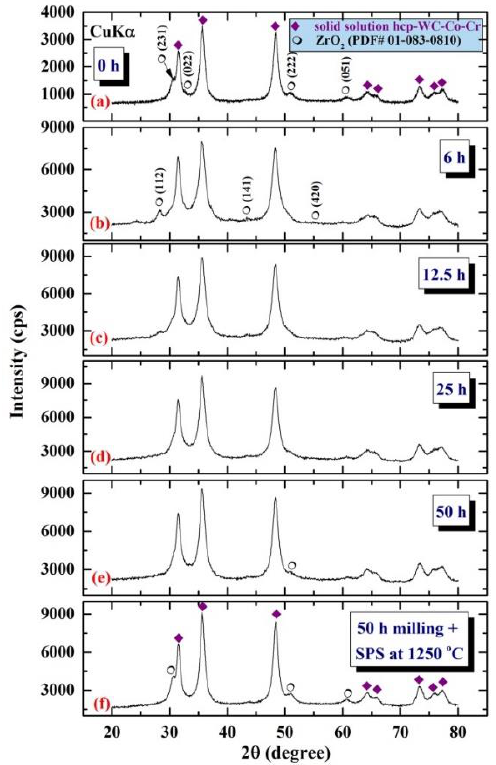
Figure 25. XRD patterns of 93-WC/7 wt. % (10Co/4Cr) powders after 50 h of milling and then mixed with 7 wt. % (ZrO 2 ) powders for ( a ) 0, ( b ) 6, ( c ) 12.5, ( d ) 25, and ( e ) 50 h. ( f ) shows the XRD pattern of nanocomposite 93(93-WC/7 wt. % (10Co/4Cr))/7 wt. % ZrO 2 . The HRTEM image of 93(93-WC/7 wt. % (10Co/4Cr))/7 wt. percent ZrO 2 powders generated after 50 h of MM is shown in Figure 6a. Numerous small grains (5–10 nm in diameter) of WC, Co, Cr, and ZrO 2 were found in the sample, as seen in Figure 26a. STEM-BFI analysis (Figure 26b) and X-ray EDS analysis (Figure 26c–h) The ultrafine WC grains (8 to 20 nm in diameter, Figure 26b–d) with lens-like morphology (Figure 26b)